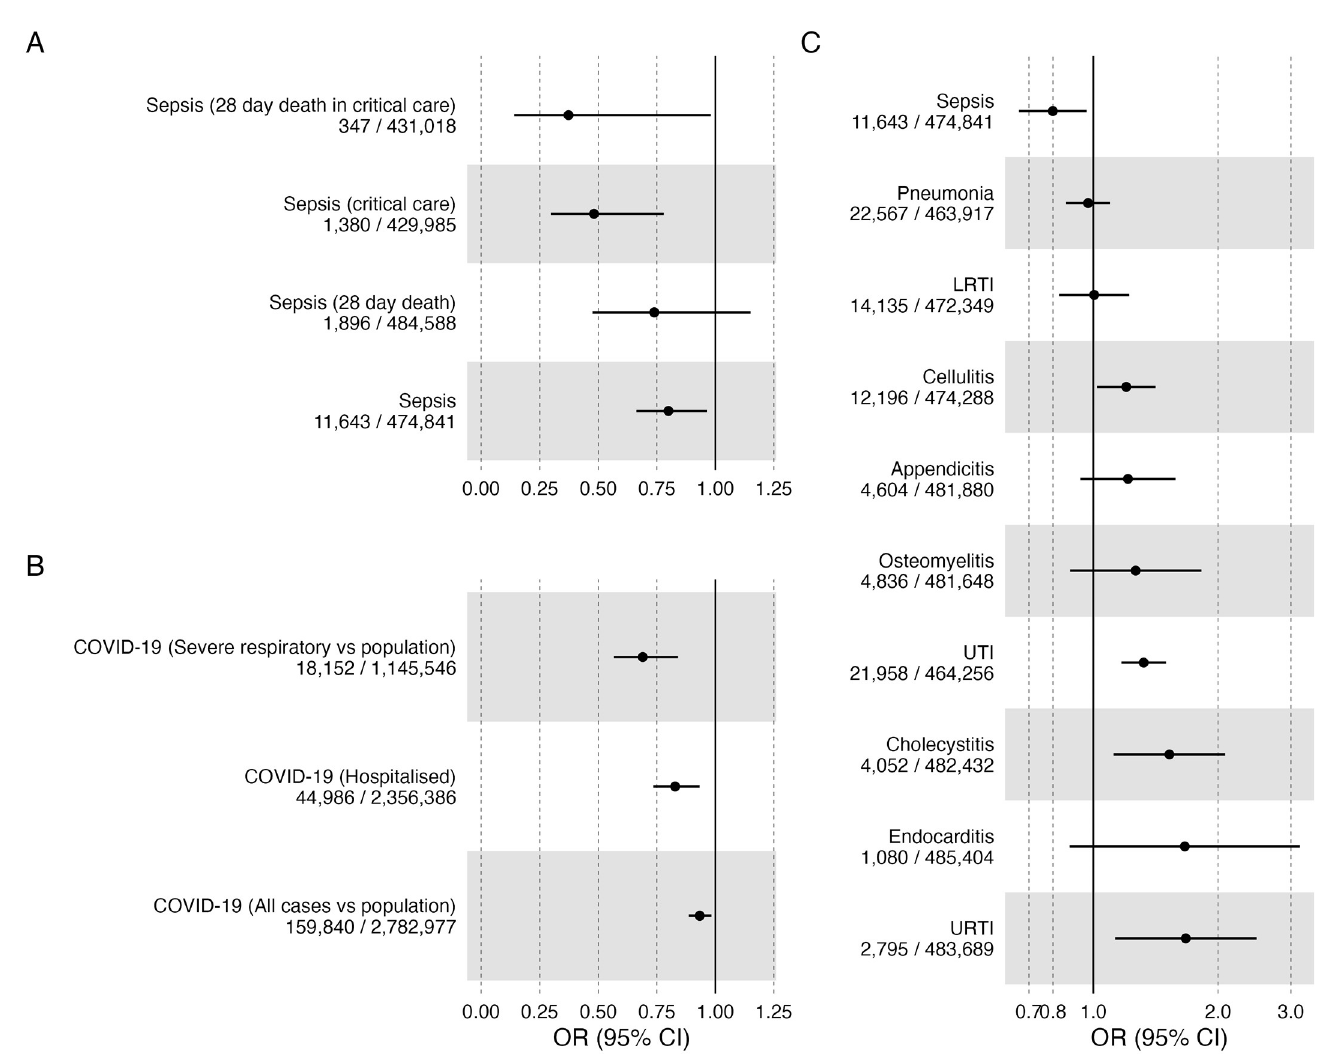
Fig 2. IVW MR estimates (ORs) with 95% CIs for IL6R blockade and each outcome (A: Sepsis, B: COVID, C: other infections) in UK Biobank. CI AU : AbbreviationlistshavebeencompiledforthoseusedinFigs 2 (cid:0) 4 : Pleaseverifythatallentriesarecorrect : , confidence interval; COVID-19, Coronavirus Disease 2019; IVW, inverse variance weighted; LRTI, lower respiratory tract infection; MR, Mendelian randomisation; OR, odds ratio; URTI, upper respiratory tract infection; UTI, urinary tract